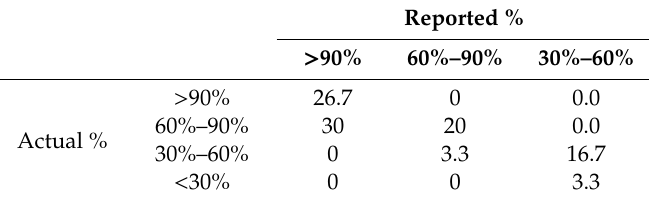
Table 7. Hearing aid usage; cross tabulation of hearing aid data logging vs. self-report ( n = 34).